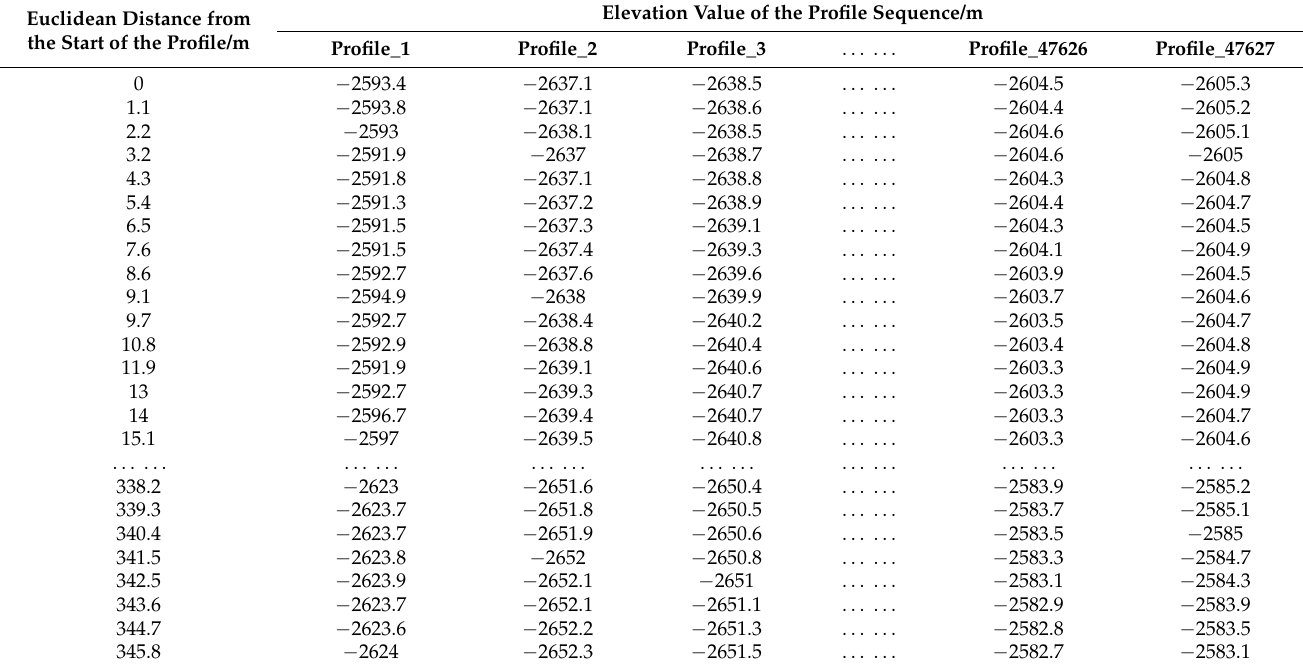
Table 1. Sequential list of elevation data for selected topographic profiles